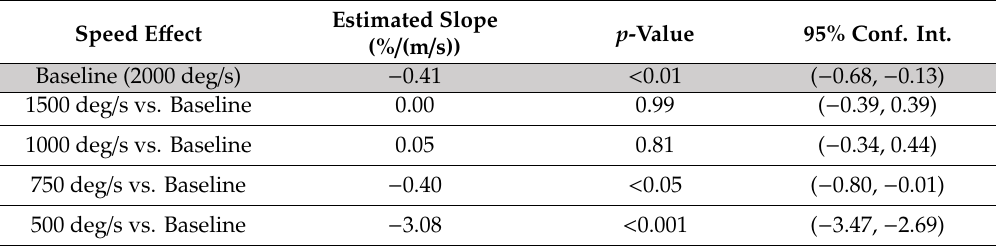
Table A2. E ff ect of speed on the cumulative distance versus gyro range. First (shaded) row reports the estimated slope of cumulative distance versus mean speed using the baseline sensor (2000 deg / s gyro). Remaining (unshaded) rows report estimated di ff erences in this slope for IMUs with indicated angular velocity ranges compared to the baseline IMU (i.e., the increased error sensitivity to speed following the indicated reductions in angular velocity range relative to the baseline